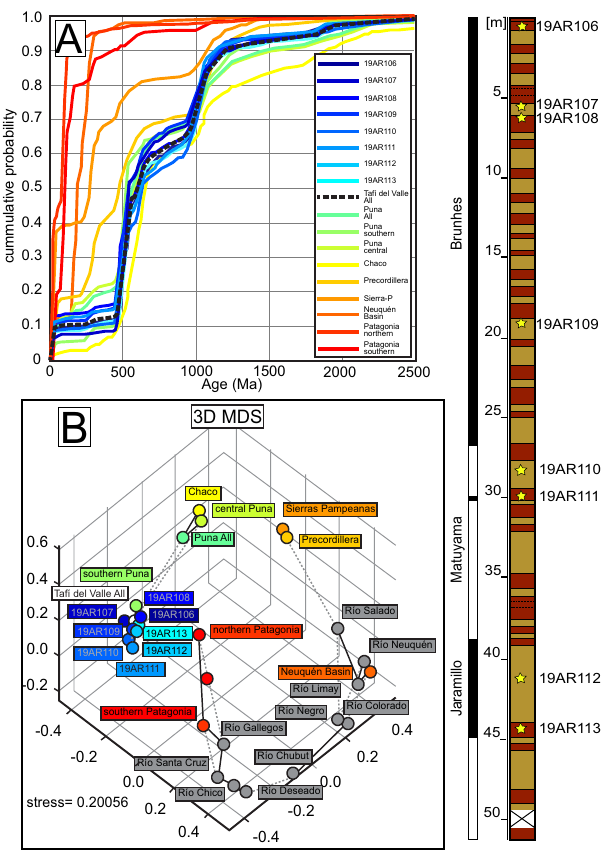
Fig. 2 U-Pb detrital zircon data. A U-Pb detrital zircon cumulative density functions for Tafí del Valle samples and comparison data. References for comparison data in the Fig. 1 caption with descriptions in Supplementary Table S2. B 3-dimensional multi-dimensional scaling (MDS) plot of U-Pb detrital zircon data for Tafí del Valle samples and comparison data. Measured and sampled stratigraphy, correlated with magnetostratigraphic timescale from Schellenbreger et al. (ref. 29 ); tan denotes loess and crimson denotes paleosol layers. 0 meters represents the top of the section and youngest